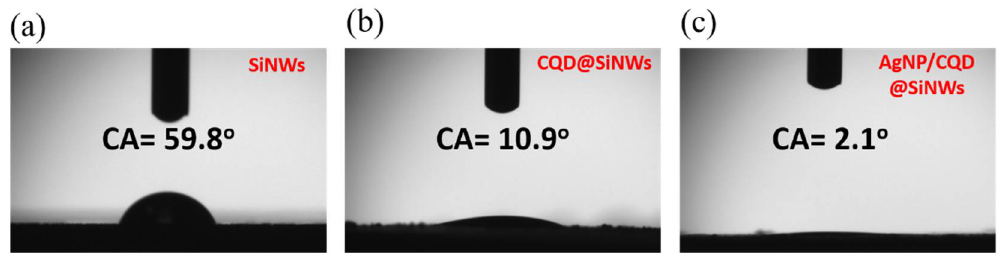
Figure 6. Contact-angle photographs of three various samples. Table 1. Measured results of zeta potential and contact angles of various